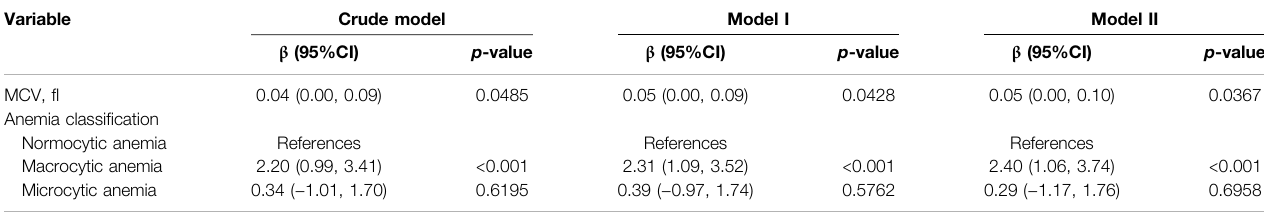
TABLE 3 | Relationship between MCV and MELD in different models. Variable